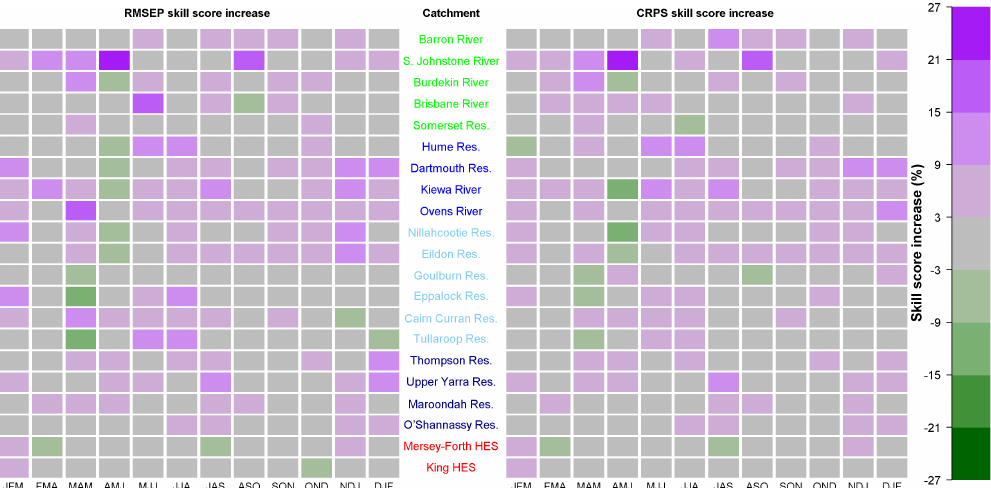
Fig. 4. Increase in skill scores of forecasts achieved by replacing selected predictors representing initial catchment conditions with WAPABA simulations and lag-1